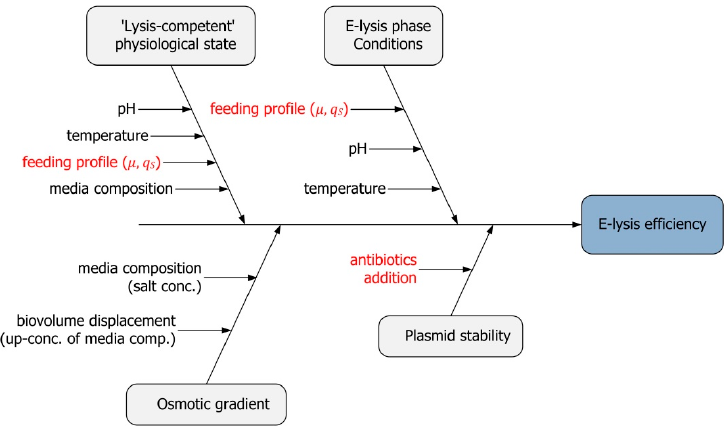
Figure 1. Ishikawa diagram depicting the potential critical process parameters as a result of a risk assessment. The critical process parameters potentially affecting the critical quality attribute of lysis efficiency are marked in red and were selected for further studies.